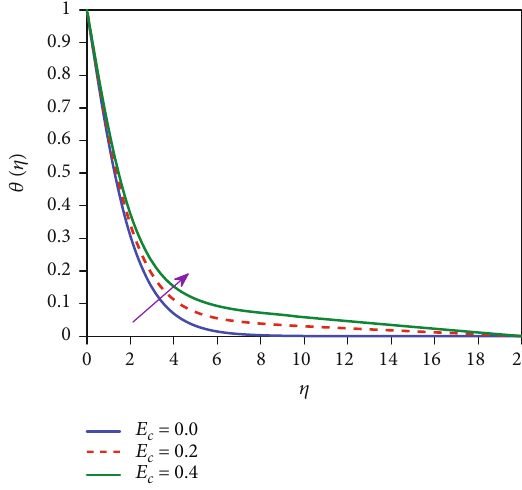
Table 2 speci fi es the impact of physical parameters on the